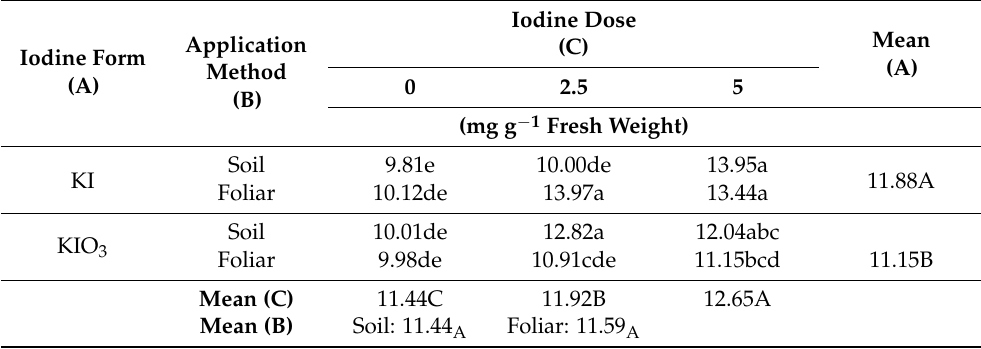
Table 2. Content of chlorophyll in rye plants depending on I dose, form, and method of